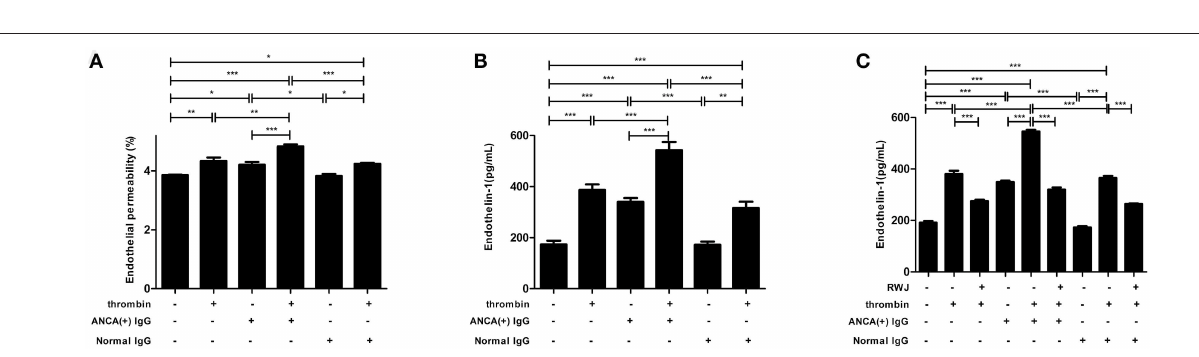
FIGURE 2 | (A) Thrombin could induce increased endothelial permeability of GEnC monolayers in the presence of MPO-ANCA-positive IgG. (B) Thrombin could upregulate ET-1 levels in the supernatant of GEnCs in the presence of MPO-ANCA-positive IgG. (C) PAR1 mediated the thrombin-induced ET-1 upregulation in GEnCs in the presence of MPO-ANCA-positive IgG. Bars represent mean ± SD of repeated measurements of five independent experiments or donors. * P < 0.05, ** P < 0.01, *** P <